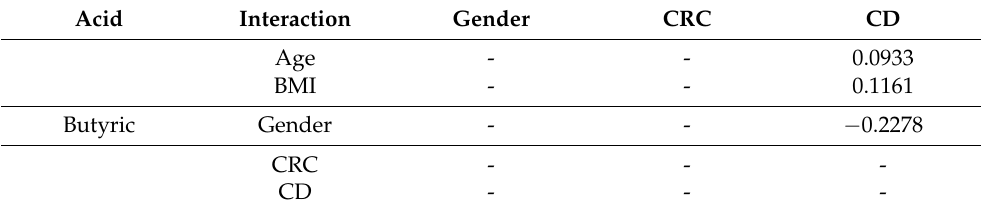
Table 5. Interaction effects evaluated with Dirichlet-multinomial regression between butyric acid, age, BMI, gender, CRC, and CD variables. Baseline category for gender is female and baseline category for state is AP. BMI = body mass index; HC = healthy controls; CD = celiac disease; AP = adenomatous polyposis; CRC = colorectal cancer.